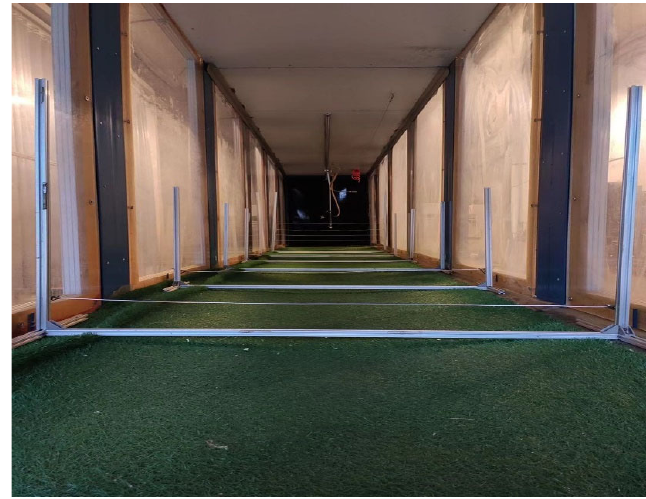
Figure 2. Measurement system of deposition distribution. 1. Water tank; 2. Return water pressure regu ‐ lating valve; 3. Liquid pump; 4. Spray pressure regulating valve; 5. Timing relay; 6. Flowmeter; 7. Pres ‐ sure gauge; 8. Wind tunnel; 9. Nozzle; 10. Vertical collection rack; 11. Horizontal collection rack.